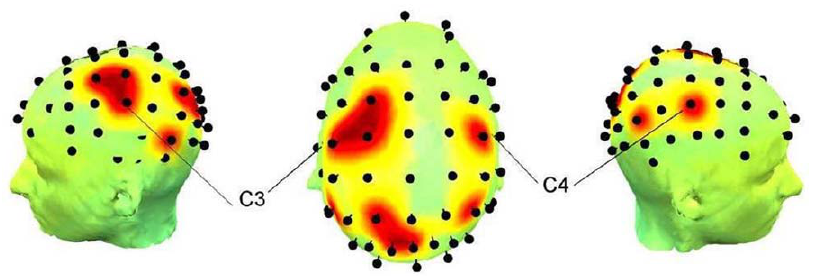
Figure 5. P maps from the left, top and right views. Each point corresponds to the location shown in Table 4, indicating significantly different degree across subjects at a cost of 0.28. C3 and C4 were the channels showing strongly enhanced degree during a task ( p , 0.00086).